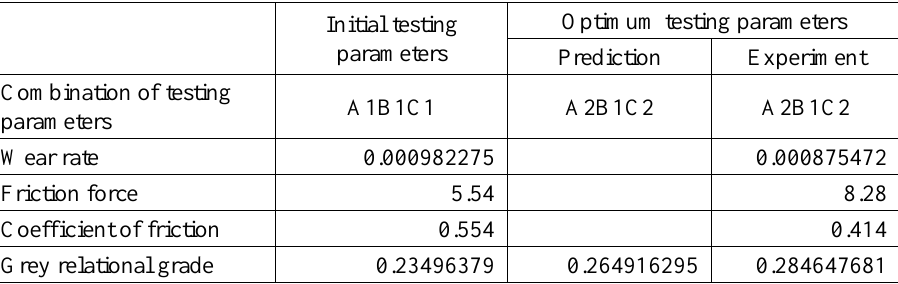
Table 12. Results of confirmation